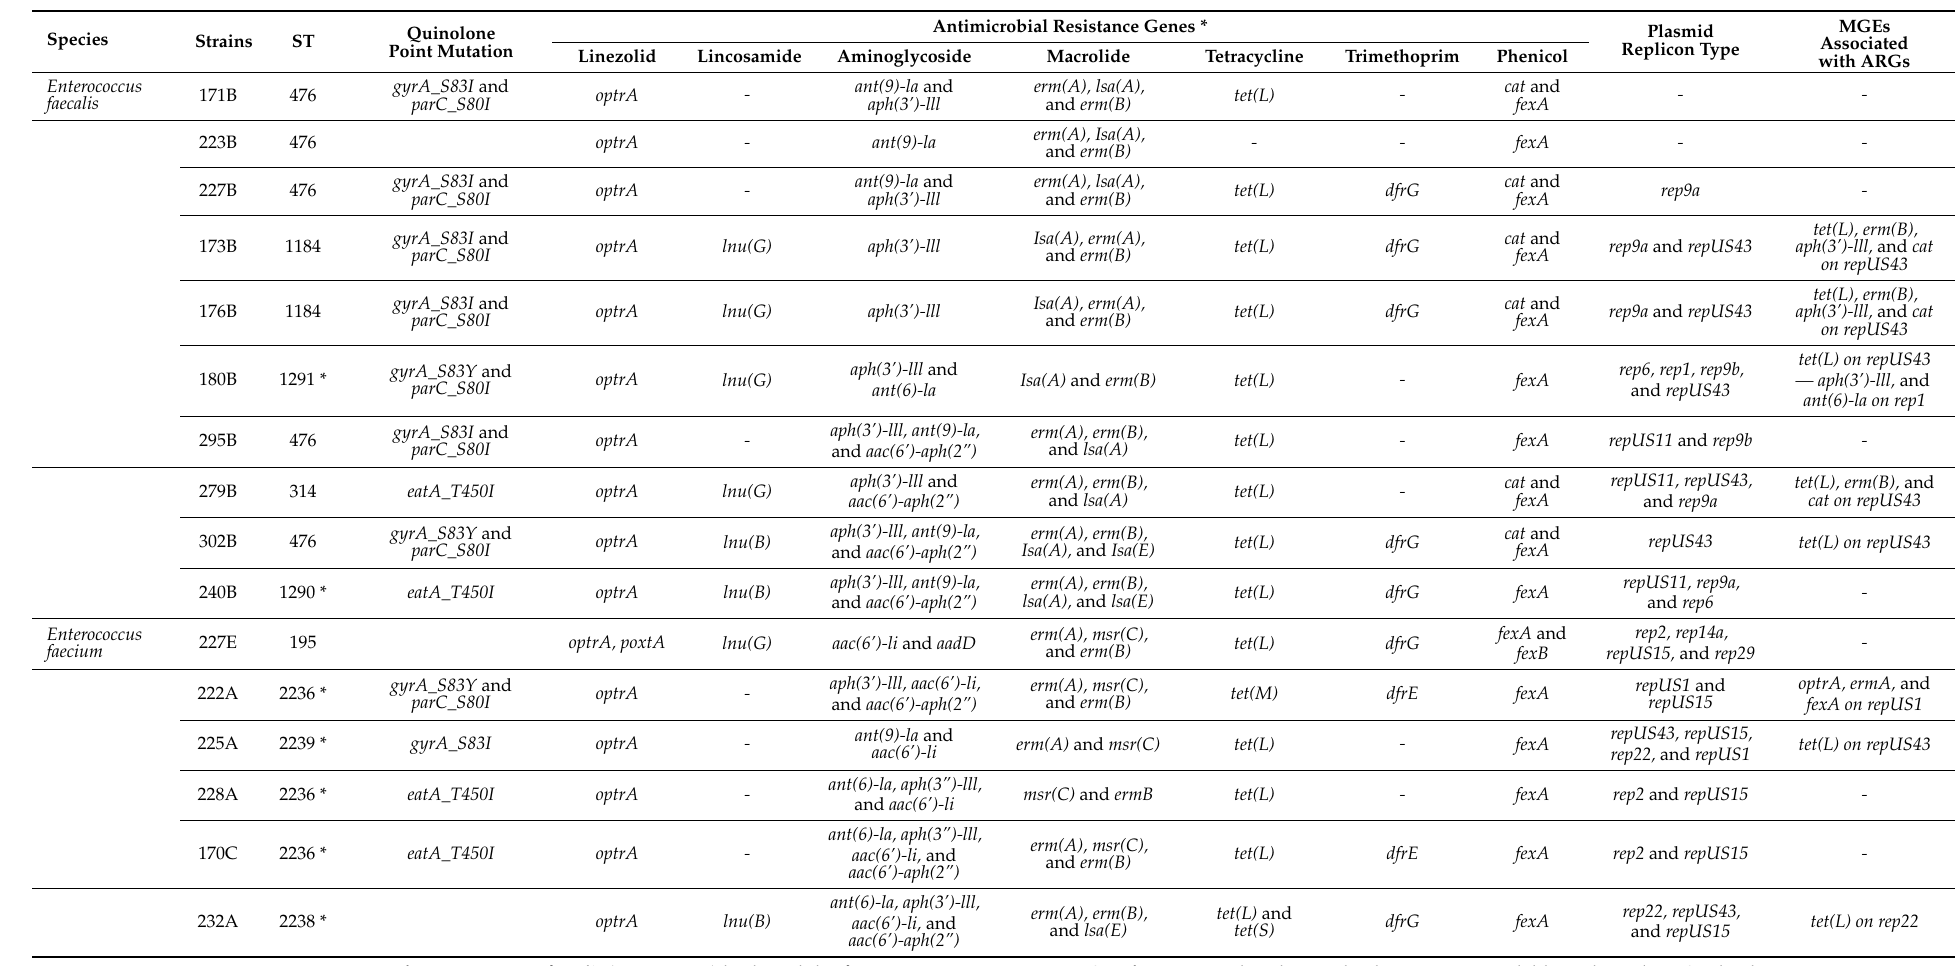
Table 2. Distribution of the multilocus sequence types (STs) and the clonal complexes (CCs), antimicrobial resistance determinants, and mobile genetic elements (MGE) in the sixteen optrA -carrying linezolid-resistant Enterococcus spp. strains from retail chicken